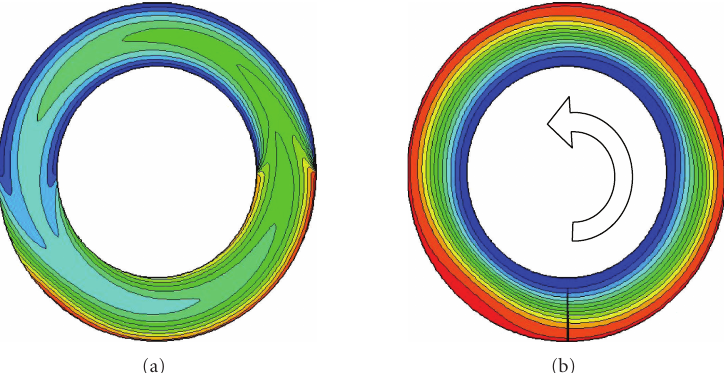
Figure 5: Steady motion in a convective regime; Ra = 22000, R = 1 . 6, and Pr = 5. (a) Isotherms, from 0.05 (blue) to 0.55 (red) in steps of